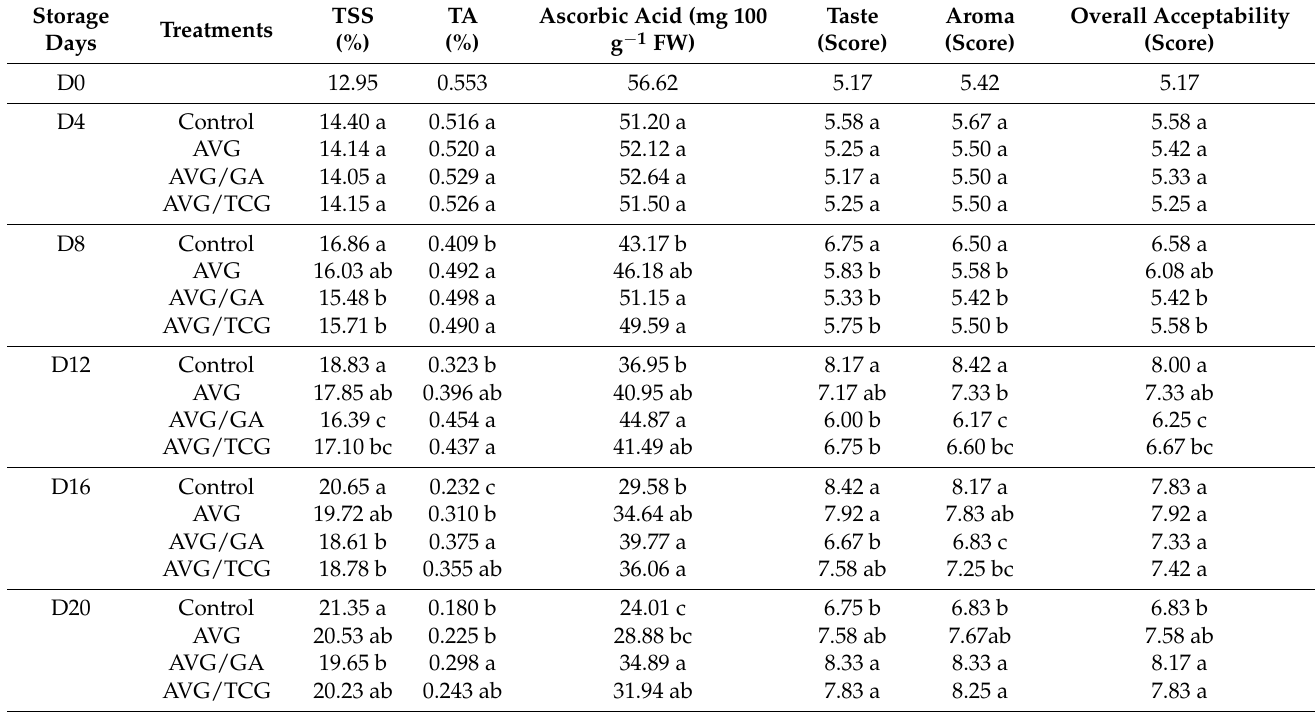
Table 1. Effect of Aloe vera gel-based composite coatings on total soluble solids (TSS), titratable acidity (TA), ascorbic acid, taste, aroma and overall acceptability in persimmon fruits during 20 days storage (20 ± 1 ◦ C and 80–85%